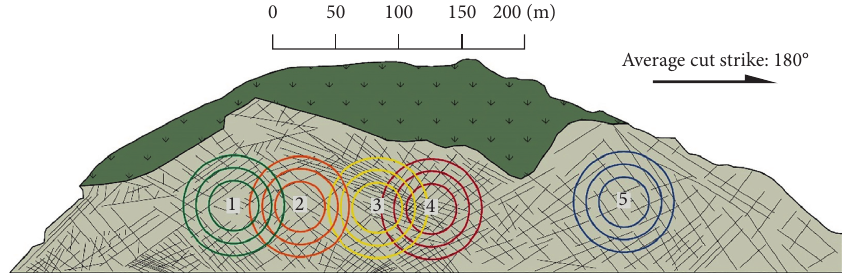
Figure 11: Sizes and locations of the circular windows used to estimate mean trace length [27]. Table 2: Estimated intensity and its % error based on circular sampling